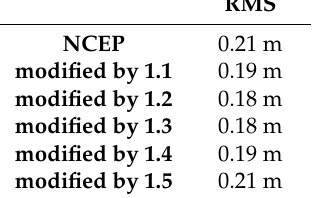
Table 6. RMS difference of non-tidal sea level anomalies between the model and tide-gauge observations at Xiamen.